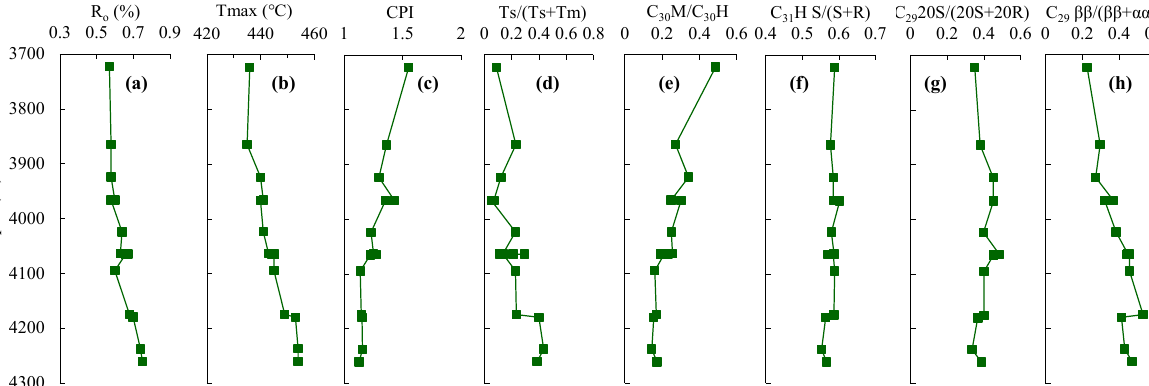
Figure 4. Variation of vitrinite reflectance (Ro; a ), T max ( b ), CPI ( c ), Ts/(Ts + Tm) ( d ), C 30 moretane/C 30 αβ -hopane (C 30 M/C 30 H; e ), C 31 αβ -homohopane 22S/(22S + 22R) ( f ), and C 29 steranes ααα 20S/(20S + 20R) ( g ) and ββ /( ββ + αα ) ( h ) with depth for the studied source rocks.